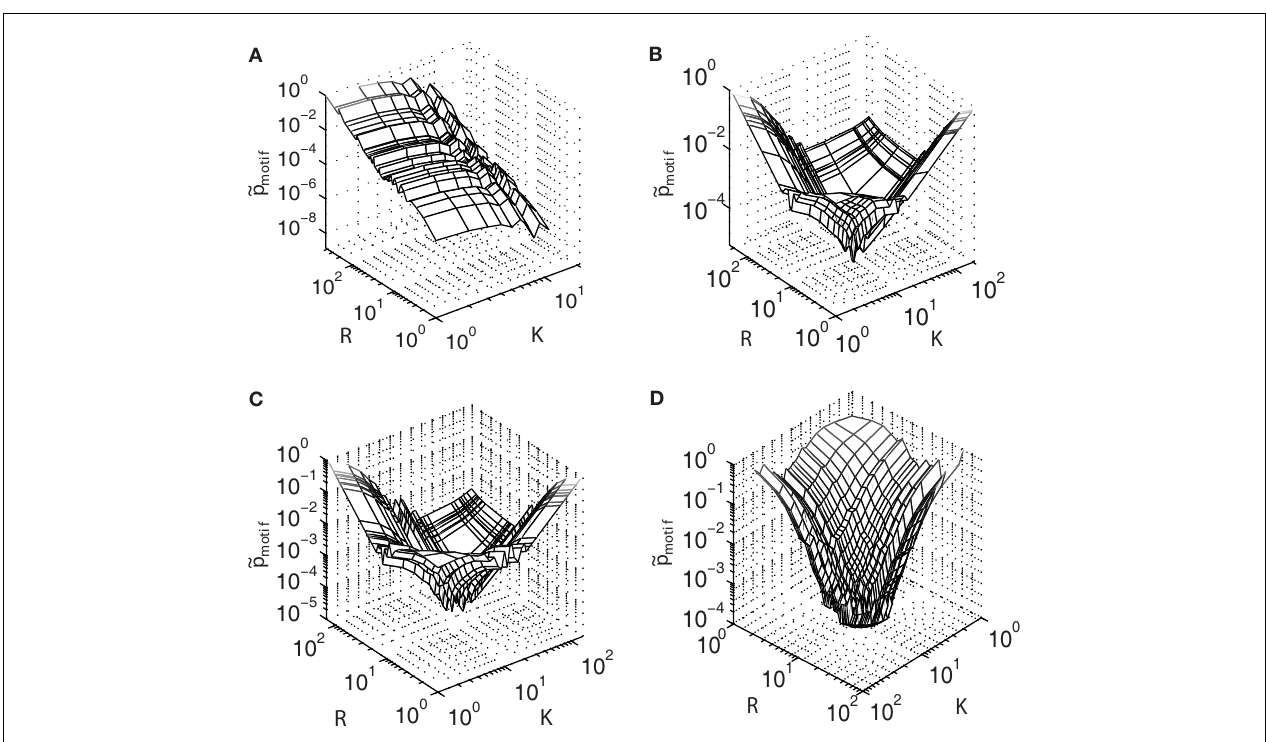
FIGURE 4 | Motif probability distributions (Eq. 6) for the (A) largest connected component of the E. coli transcriptional network, contrasted with distributions obtained from model networks built using (B) linear attachment kernels, (C) power-law kernels, and (D) sigmoidal type kernels.